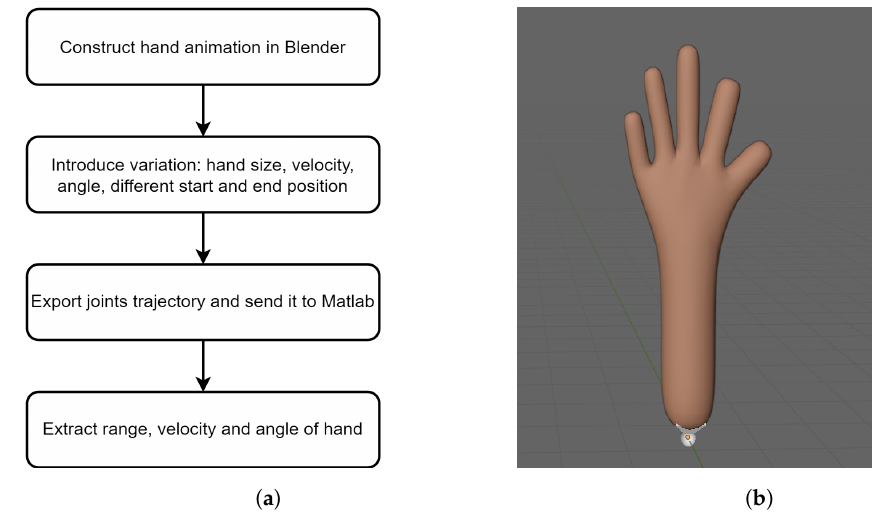
Figure 6. ( a ) The workflow of the gesture feature synthesiser; ( b ) an example of hand animation.